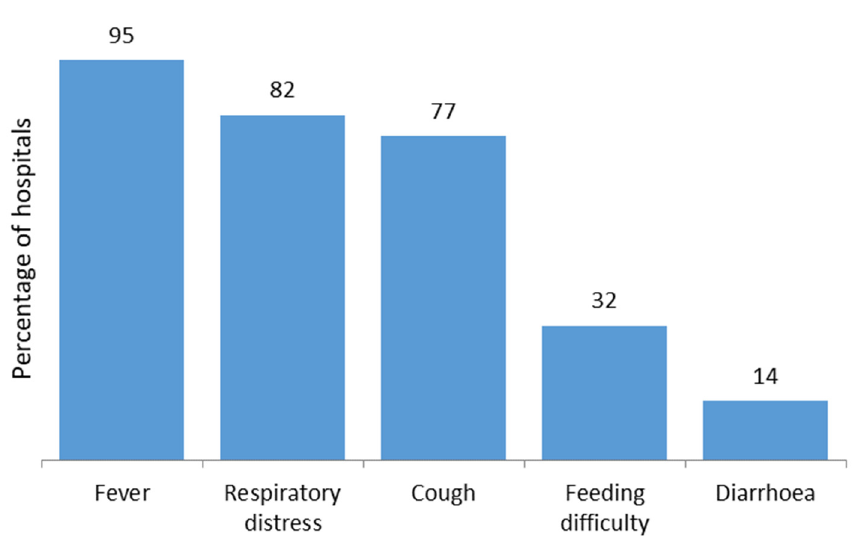
Figure 1. Reasons for hospital admission of children with COVID-19 ( n = 146). Table 4 contains the consolidated list of antibiotics (class or specific) prescribed for children with suspected or confirmed COVID-19 among the participating hospitals. As seen, there was a considerable prescribing of antibiotics, with 86.3% (126/146) of children prescribed them, with almost all antibiotics administered empirically (98.4%—124/126). In general, antibiotics were prescribed from the WHO Watch list as opposed to the Reserve list. In addition, antibiotics were typically administered parenterally with generally